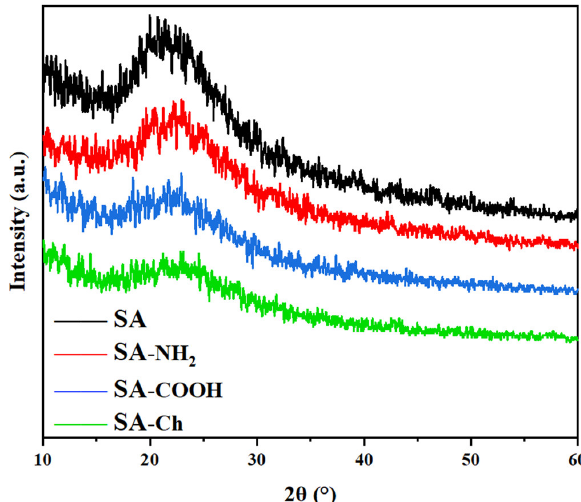
Figure 2. XRD patterns of the original and modified SAs.